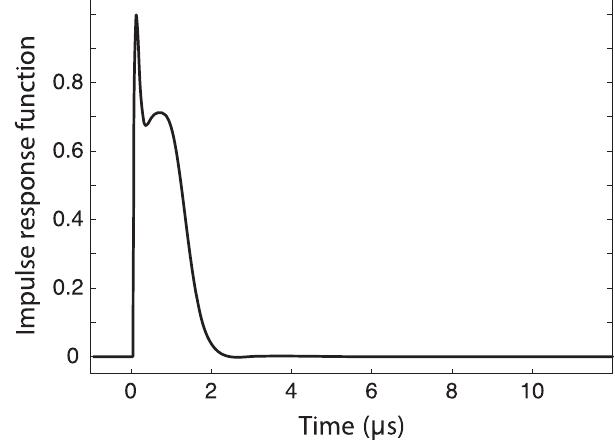
FIG. 6. Reconstructed impulse response function. The control bandwidth is mainly limited [48] by a time delay, which originates from the acousto-optical modulators employed in the optical phase-locked loop to control the phases ϕ R;L ð t Þ ; see Appendix